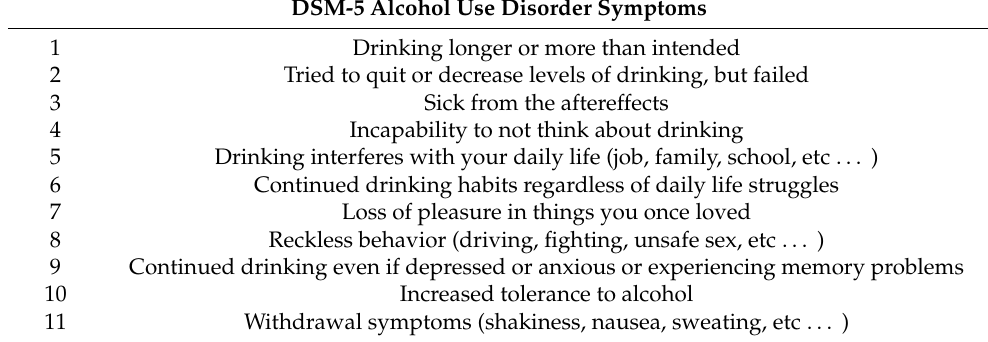
Table 1. DSM-5 symptoms for Alcohol Use Disorder (AUD. The presence of 2 or more of these 11 listed symptoms indicates Alcohol Use Disorder (AUD) [45]. Levels of severity are classified as Mild: 2–3 symptoms, Moderate: 4–5 symptoms, and Severe: 6 or more symptoms. Modified from the DSM-5 questionnaire given to patients